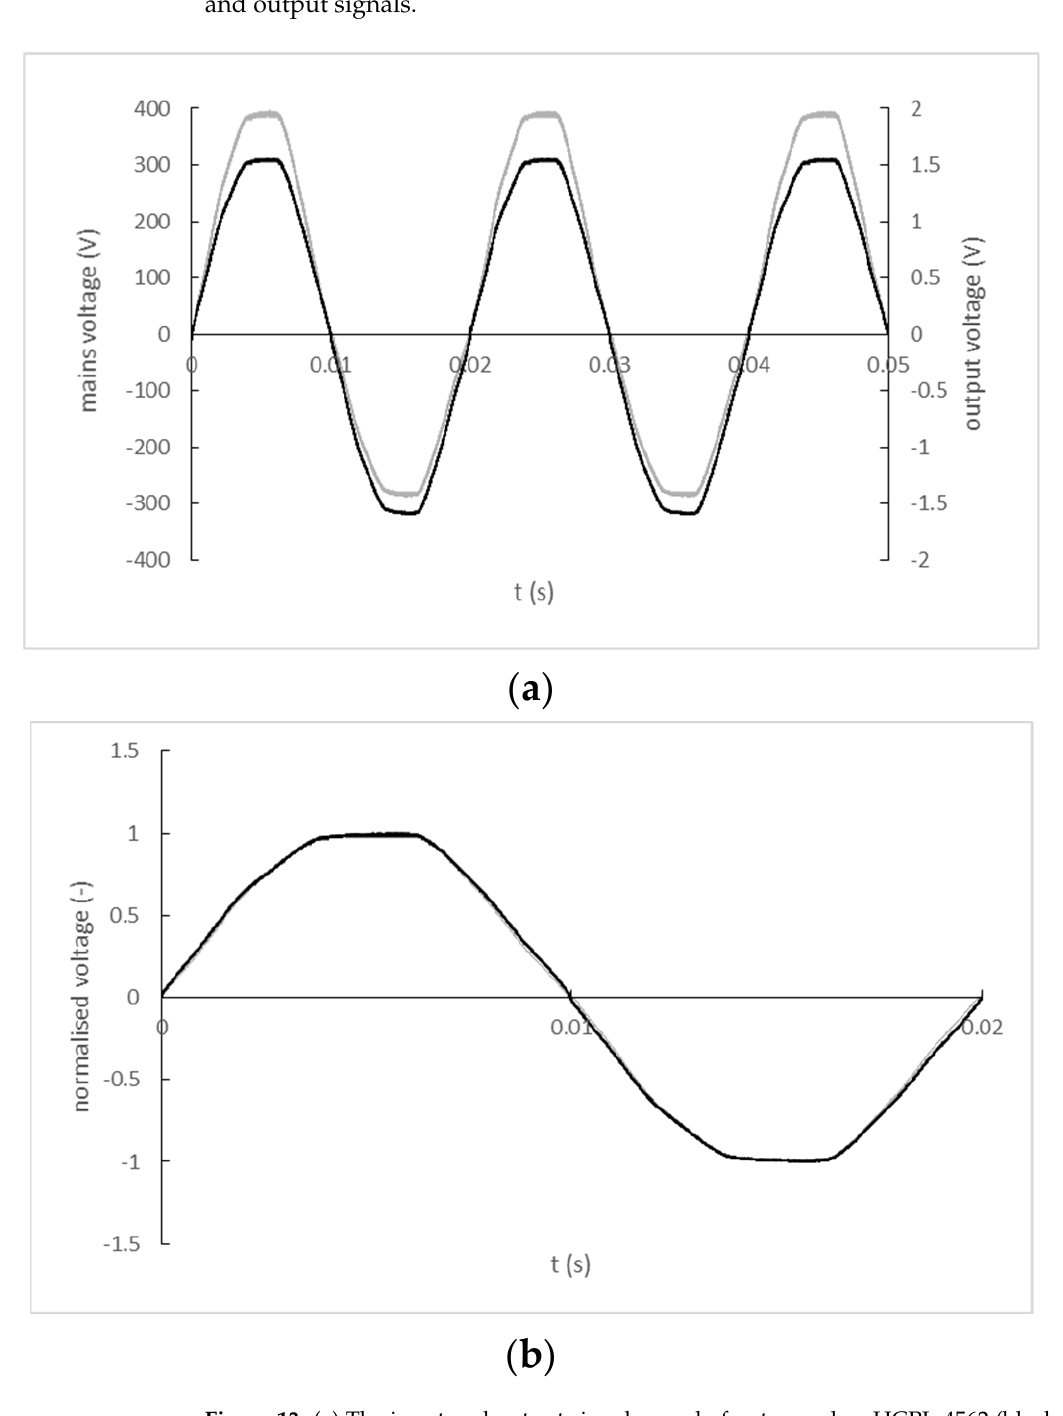
Figure 13. ( a ) The input and output signal record of optocouplers HCPL-4562 (black line—mains; grey line—output); ( b ) Normalized input and output waveforms of optocouplers HCPL-4562 (black line—mains; grey